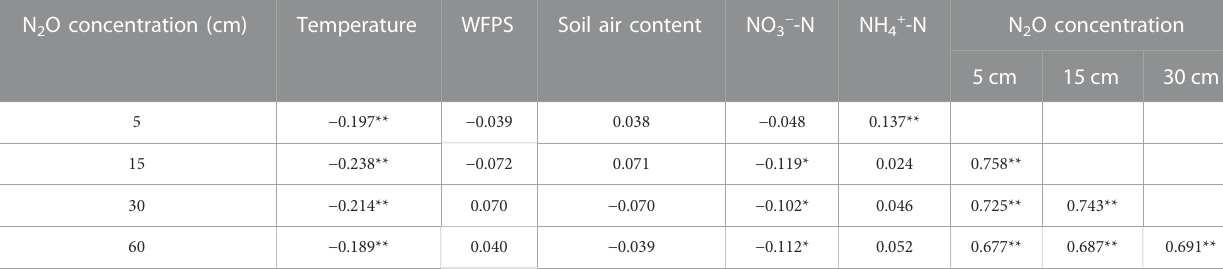
TABLE4Pearsoncorrelationcoef fi cients( n =448)betweenN 2 Oconcentrationandtemperature,WFPS,aircontentat5,15,30,and60 cmdepths,aswellasNO 3 − -N and NH 4 + -N of 0 – 20 cm top soil. N 2 O concentration